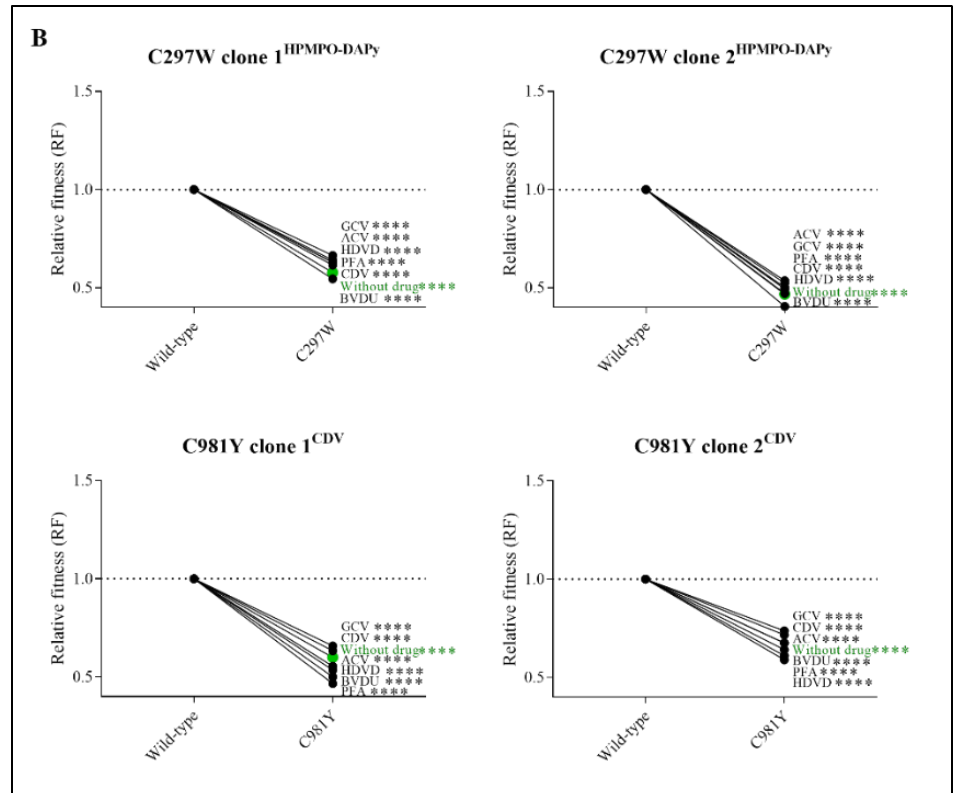
Figure 3. Relative fitness (RF) of MHV-68 wild-type (WT) and drug-resistant clones ( A ) or mutator phenotype viruses ( B ) in growth competition assays in the absence and presence of antiviral drugs. Competition between mutant versus wild-type virus was evaluated without drug (in green) and in the presence of ACV (9 µM), GCV (8 µM), BVDU (1.50 µM), HDVD (0.20 µM), CDV (1.60 µM) or PFA (160 µM). Additionally, the viral mutant Y383S GCV was evaluated with a ratio of 80:20 of Y383S GCV /MHV-68 wild-type. Values represent the means of the viral frequencies of two biological replicates, determined by NGS. Statistical significance was calculated using one-way Anova (multiple comparisons to MHV-68 wild-type virus with the Dunnett test. p < 0.01 (**), p < 0.001 (***), p < 0.0001 (****)).